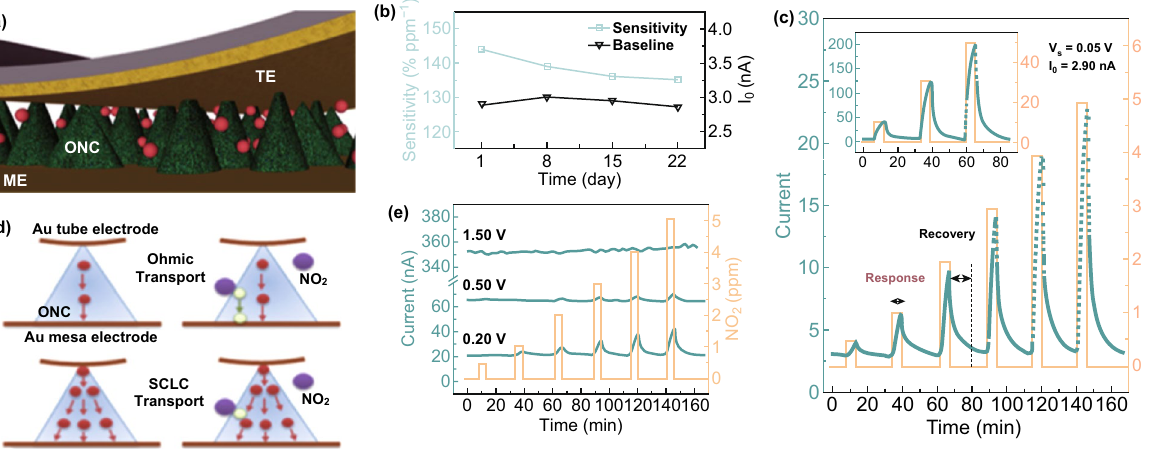
Fig. 8 a Schema of the cross section of the tube/organic/mesa structure. VOPc nanopyramids (green cones) provide sufficient space for NO 2 gas molecules to penetrate the structure. The red particles denote NO 2 gas molecules. b Stability test in ambient atmosphere: sensitivity (left axis) and baseline (right axis) over time. c Response of periodic NO 2 exposure. The device is operated under 0.05 V bias applied to the tube electrode. d Schematic diagram of charge transport and response to NO 2 under ohmic transport (upper panel) and SCLC transport (lower panel) conditions. e Response of organic nanocrystal diode sensor (device 1) at 0.20, 0.50, and 1.50 V bias applied to the tube electrode. Reproduced with permis- sion [65]. Copyright 2018, Wiley–VCH. (Color figure online)